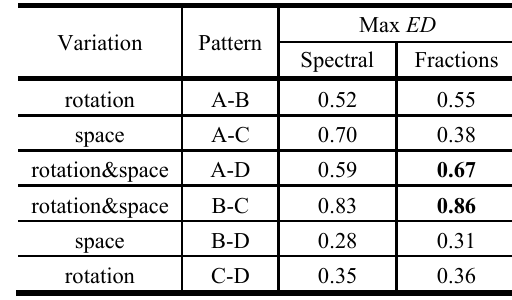
Table 1. Separability between patterns in spectral and fraction